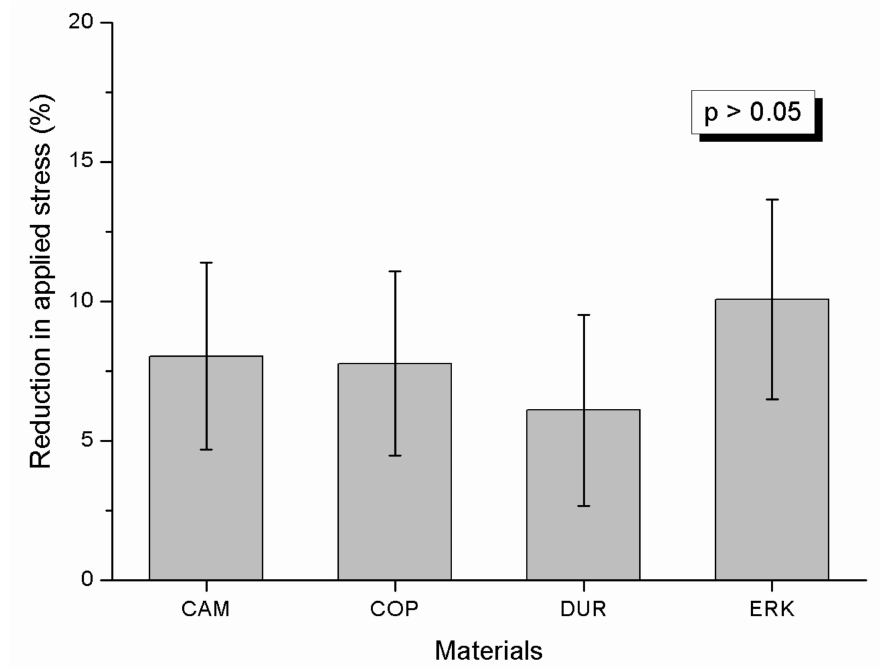
Figure 3. Box and whiskers plots of mean values and standard deviations of reduction in applied stress after 1 week for all materials tested. No statistically significant di ff erences were identified ( p >